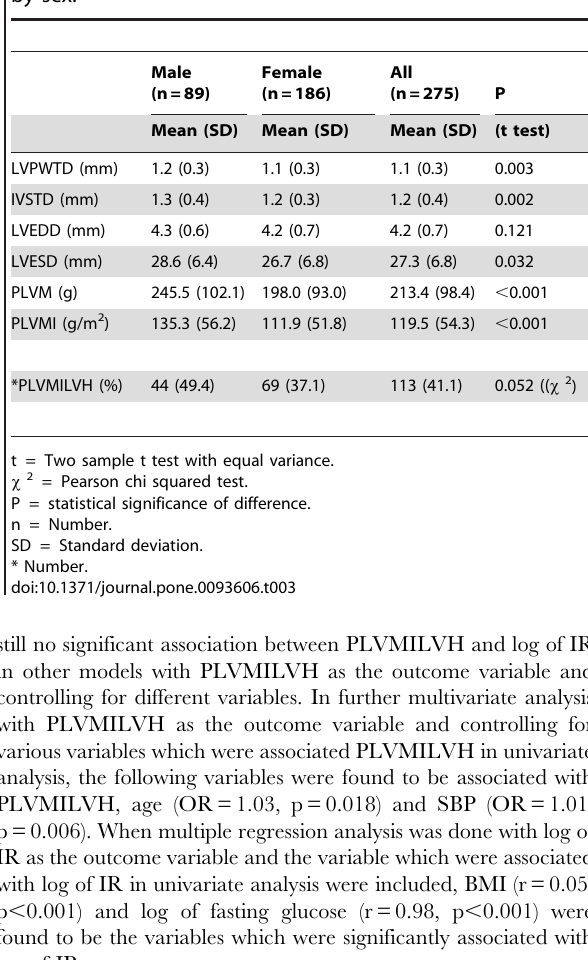
Table 3. The echocardiographic characteristics of participants by sex.